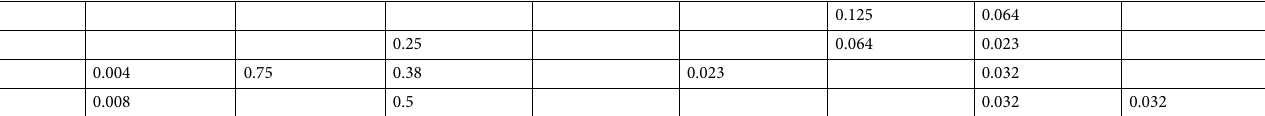
Table 2. Antibiotic susceptibility pattern of Corynebacterium macginleyi strains isolated from patients with infectious keratitis, determined as minimum inhibitory concentration. *Stored but retrieved very late therefore not sequenced. In 2 patients susceptibility testing was not performed at the time of disease episode, and later determination was not possible since the isolates were not stored or were too